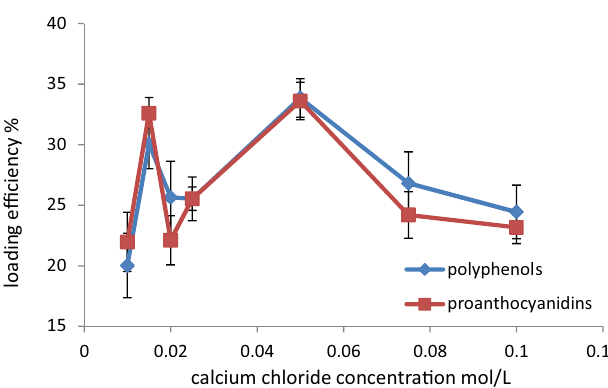
FIGURE 3 - Effect of calcium chloride exposure time on total extractable polyphenols and proanthocyanidins loading efficiency. a Values are mean ± SD, (n =